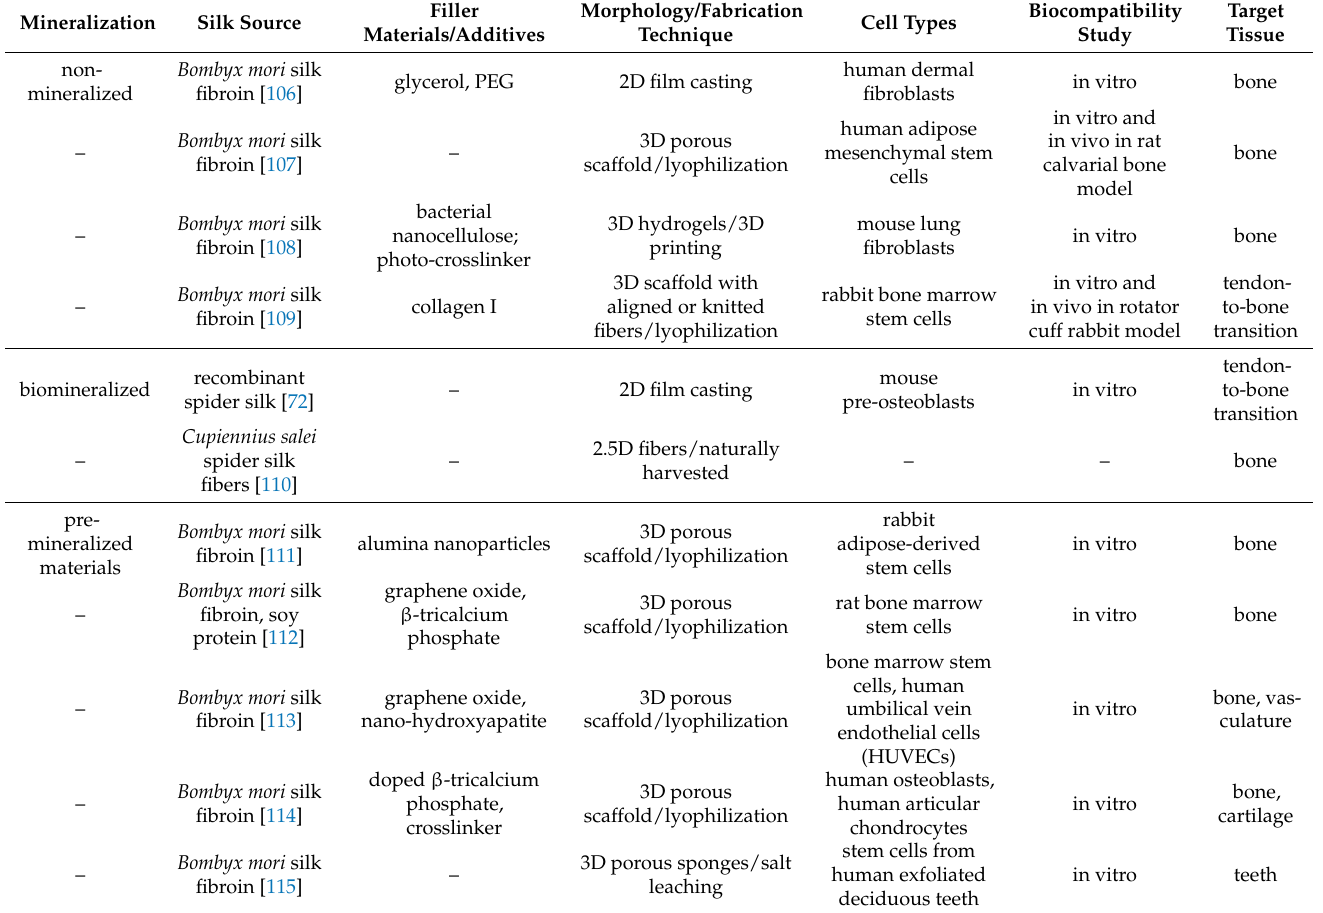
Table 1. Overview of silk-based hard tissue engineering